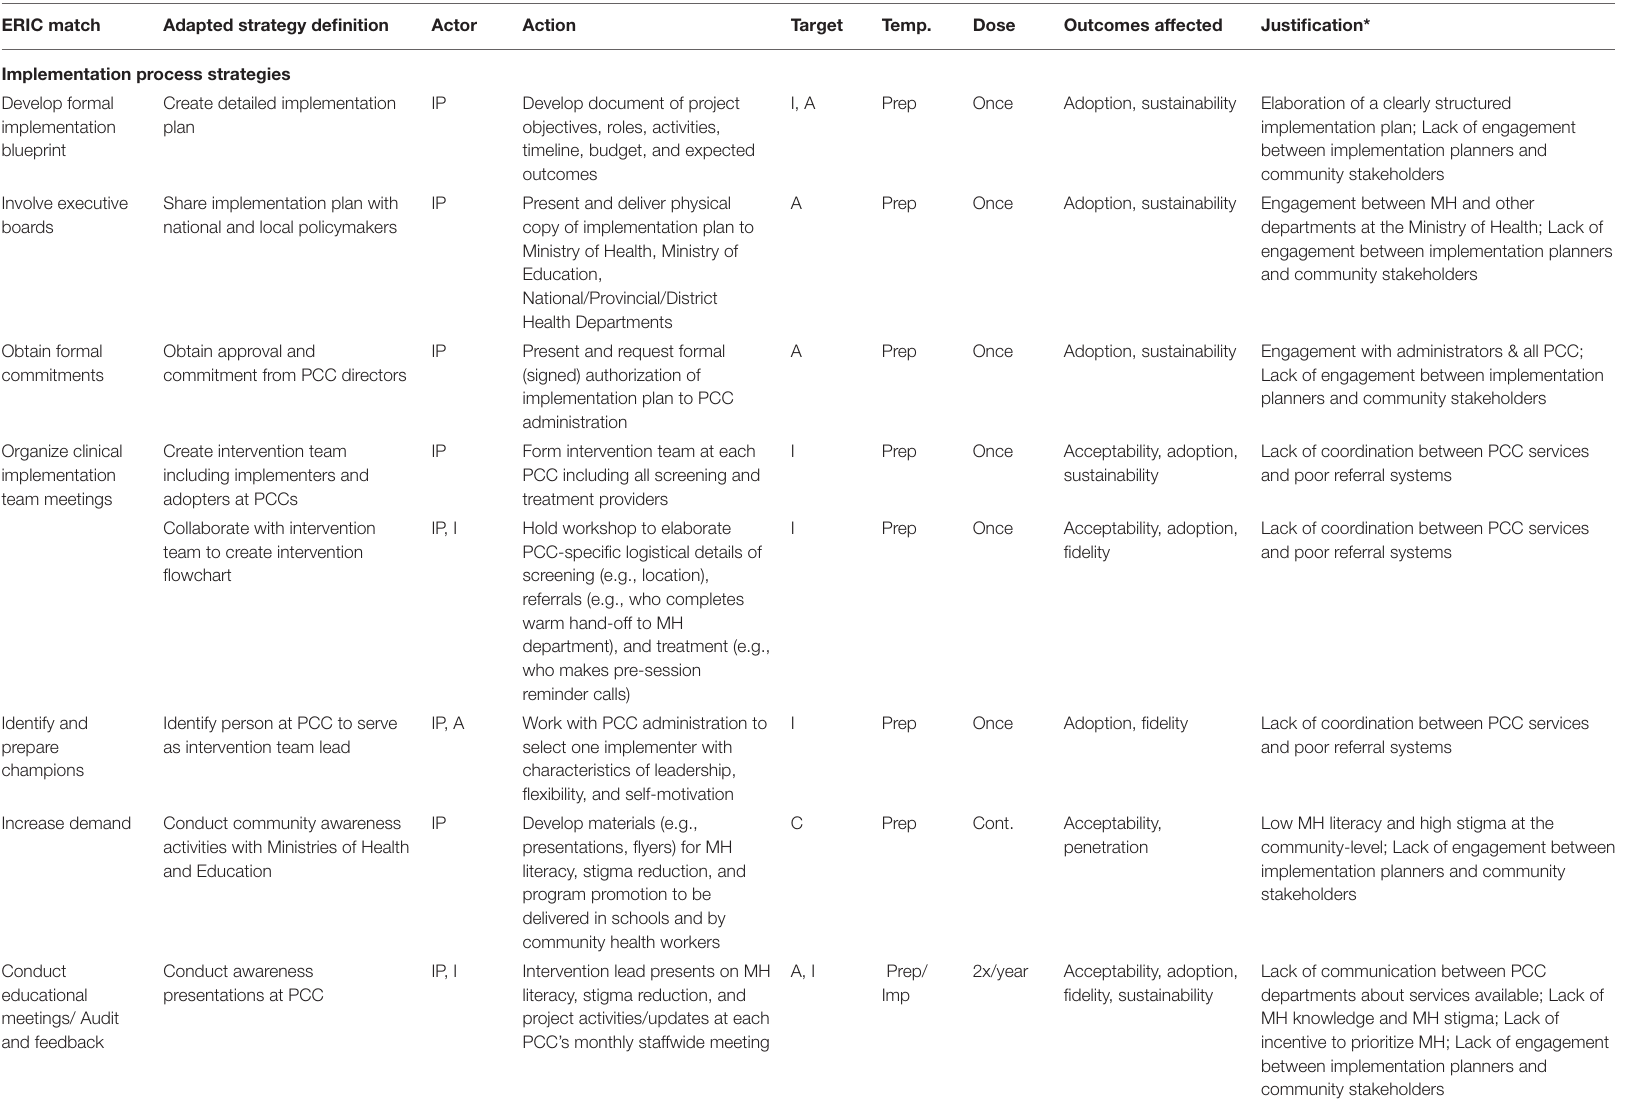
TABLE 4 | Implementation strategy specification for integrated adolescent depression services in Mozambican primary